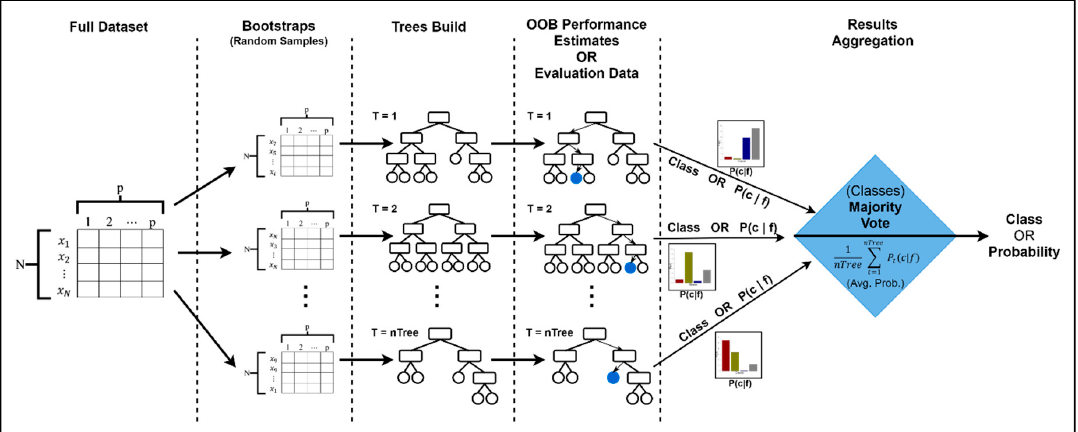
Figure 1. Main phases of Random Forest algorithm.